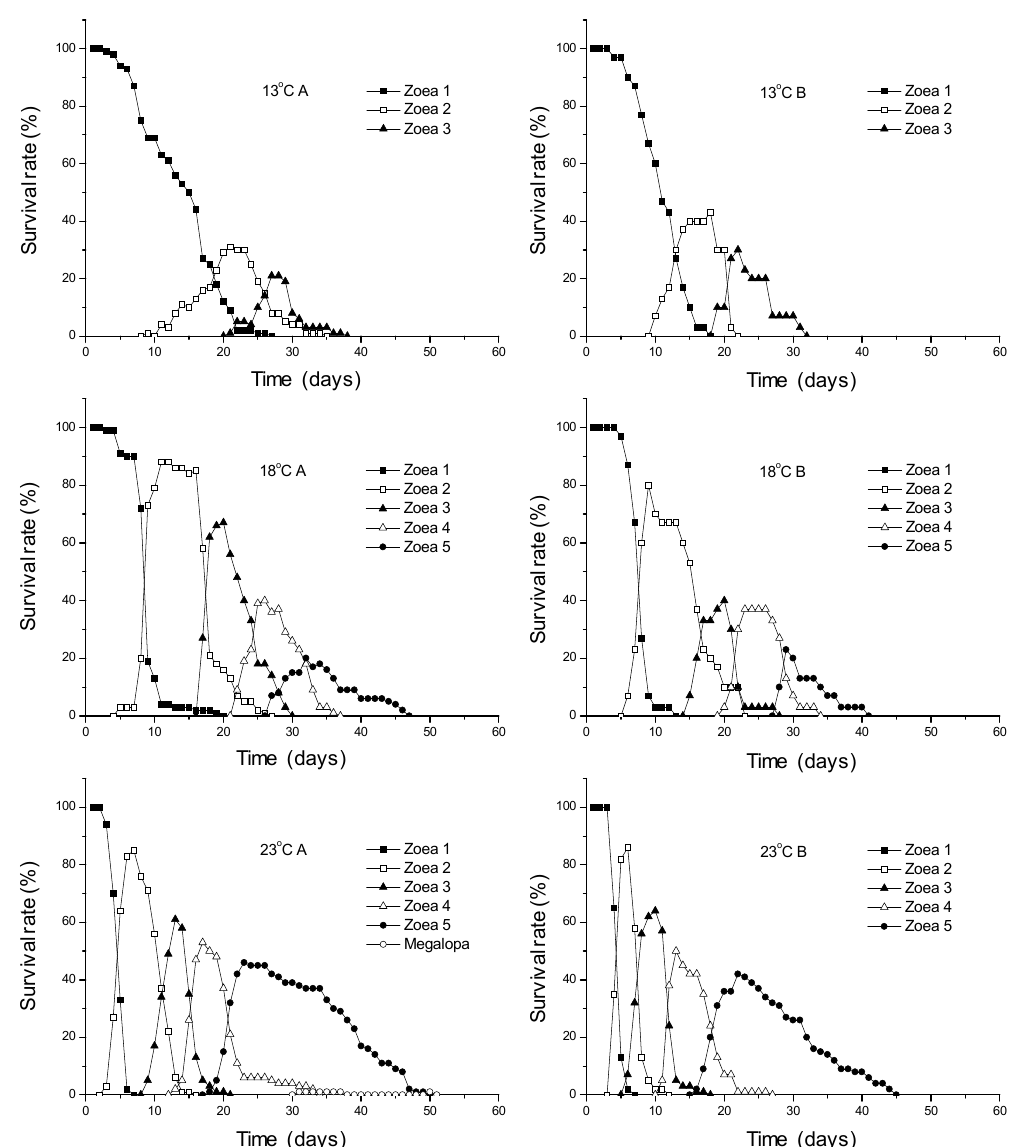
Figure 2. Survival rate (%) for each developmental stage from hatching of D. japonicus reared at 13, 18, and 23 °C.